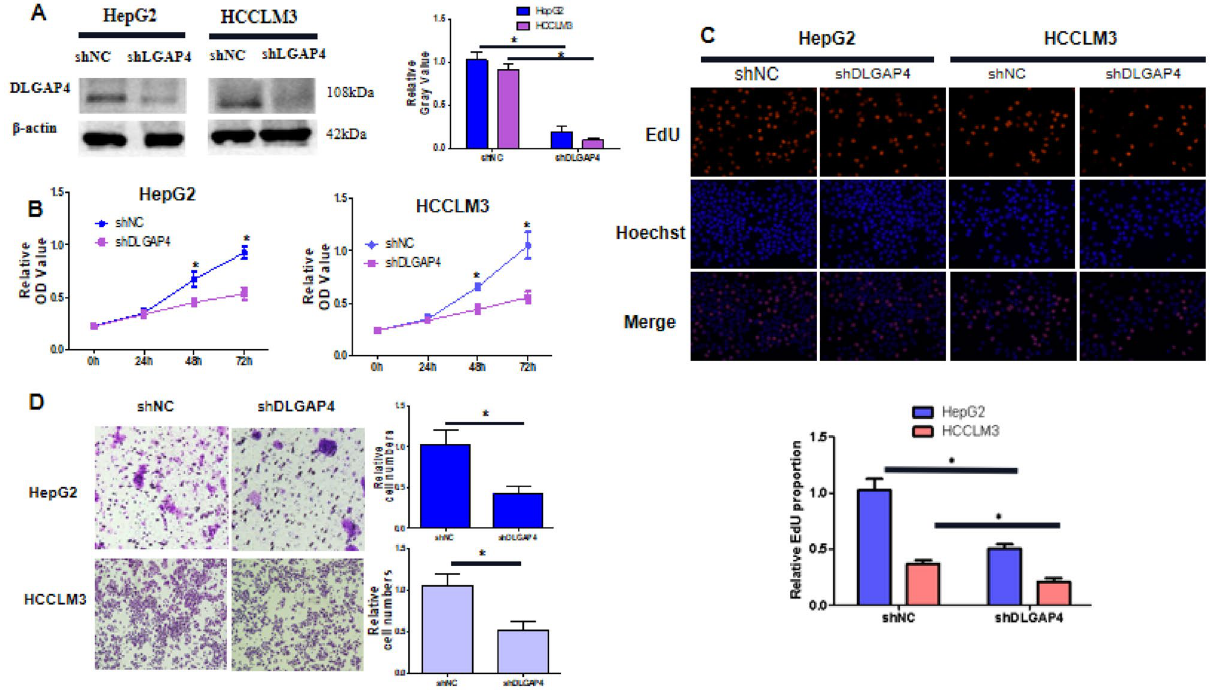
Figure 7. DLGAP4 knockdown suppresses the proliferation and growth of HCC cells in vitro. ( A ) Western blot analyses showing the expression levels of DLGAP4 in HepG2 and HCCLM3 cells stably transfected with shDLGAP4 or shNC. β-actin was used as a loading control. ( B ) CCK-8 assays revealed that shDLGAP4 inhibited the proliferation of HepG2 and HCCLM3 cells. ( C ) Representative micrographs of BrdU incorporation